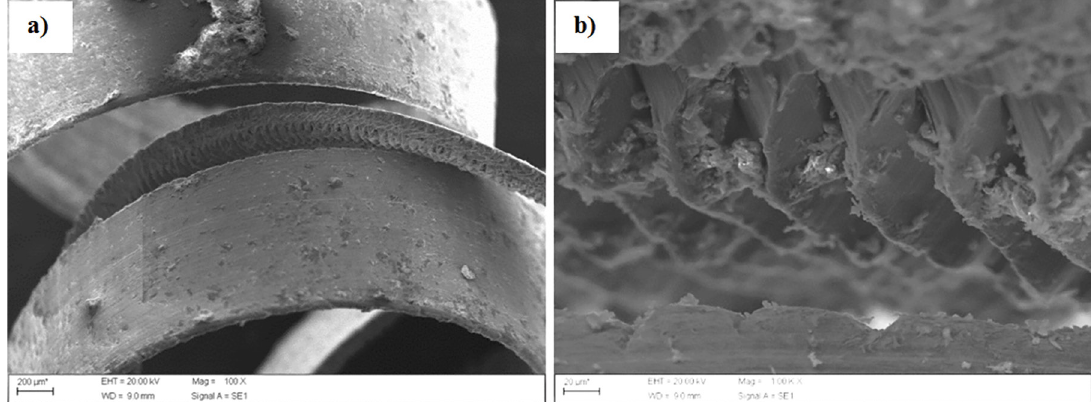
Figure 2. Morphology of the aluminum bronze chip milled for 10 hour (a); sheared surface morphology of one of chip in detail (b).